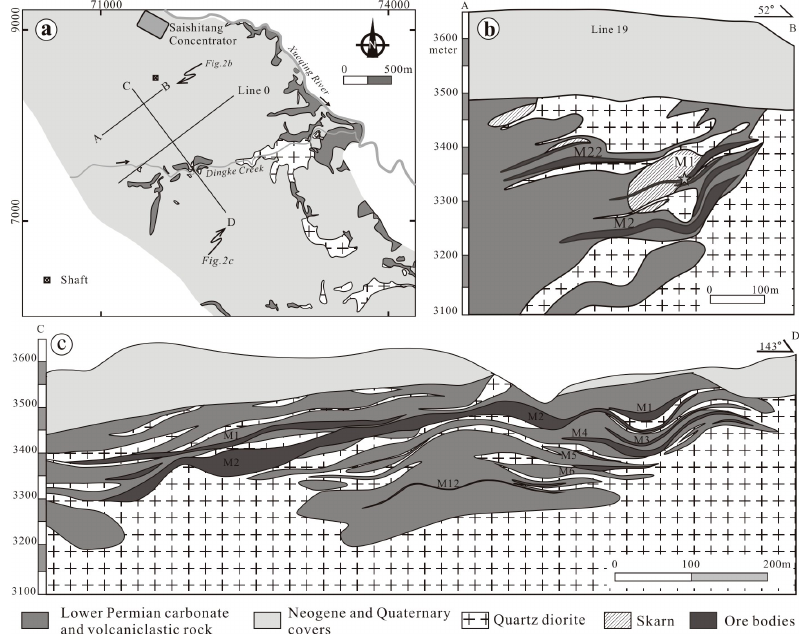
Figure 2. ( a ) Geological map; ( b ) cross section of Line 19; and ( c ) C-D section of the Saishitang Cu deposit (after [26]).